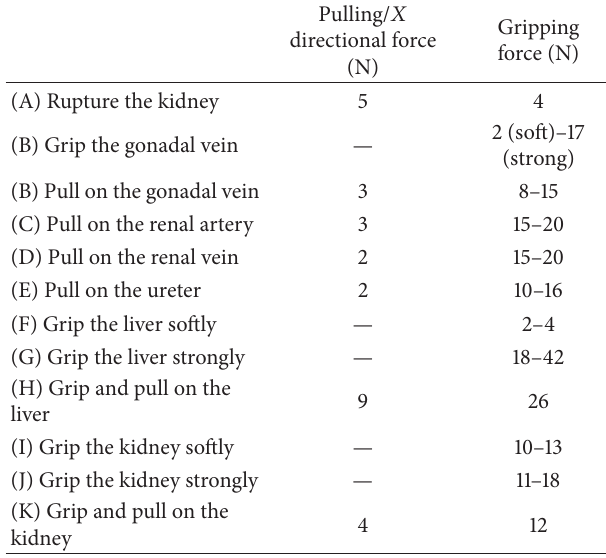
Table 2: The results of the